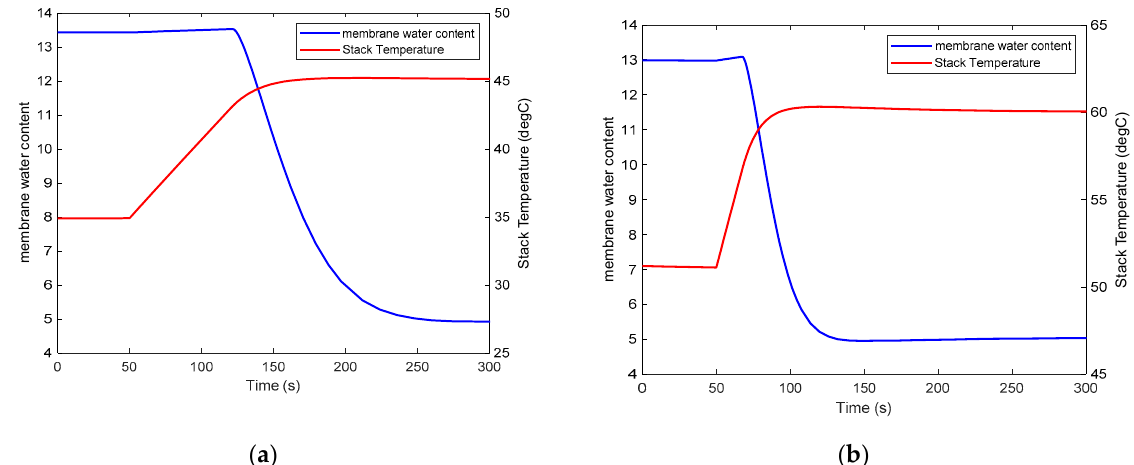
Figure 6. Humidity dynamics at under different stack temperature: ( a ) at 15 A; ( b ) at 41 A.